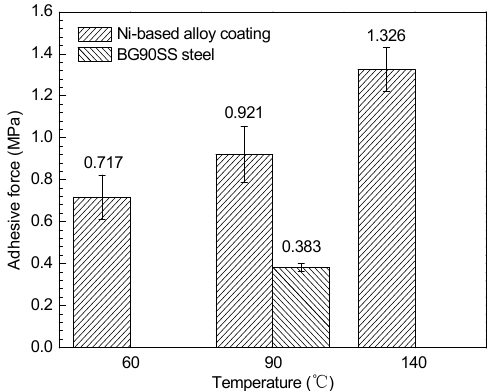
Figure 7. Adhesive force of the corrosion scale on the Ni-based alloy coating and BG90SS steel exposed to the H 2 S/CO 2 environment for 168 h at different temperatures.